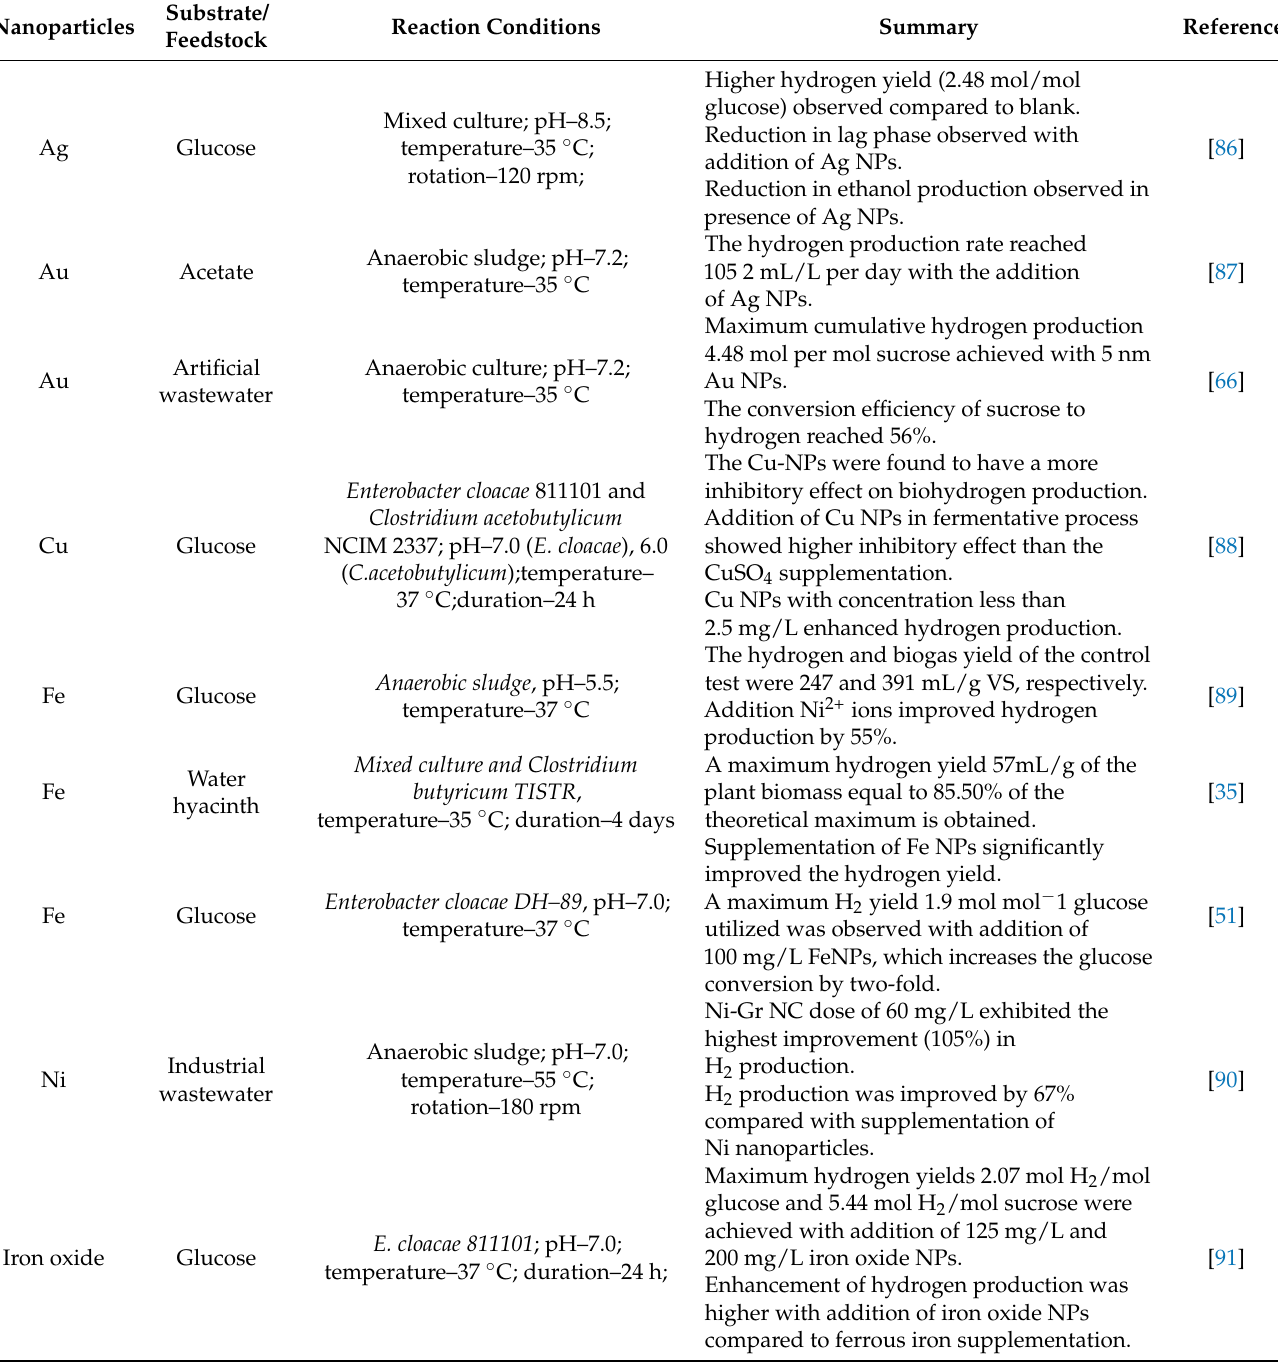
Table 1. Summary of application of nanoparticles in biohydrogen production